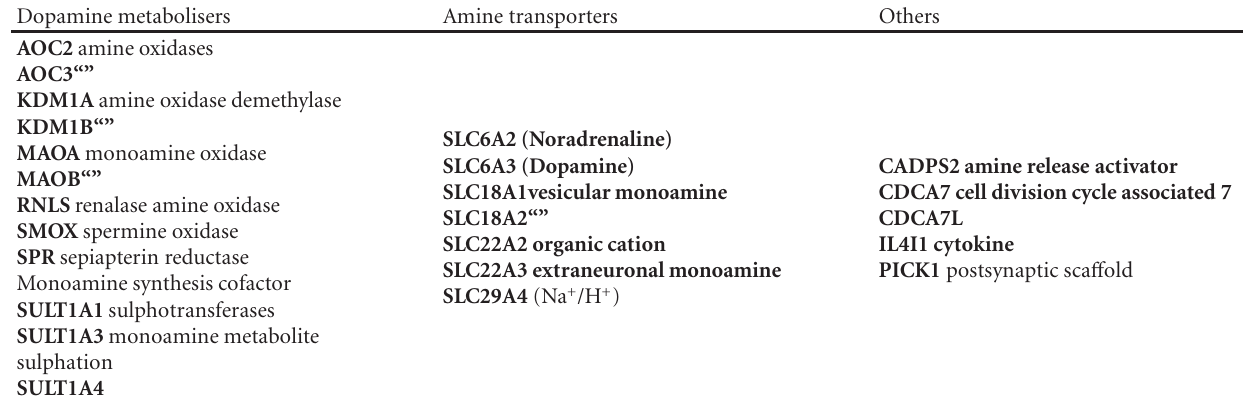
Table 6: Human homologues of Norwalk virus